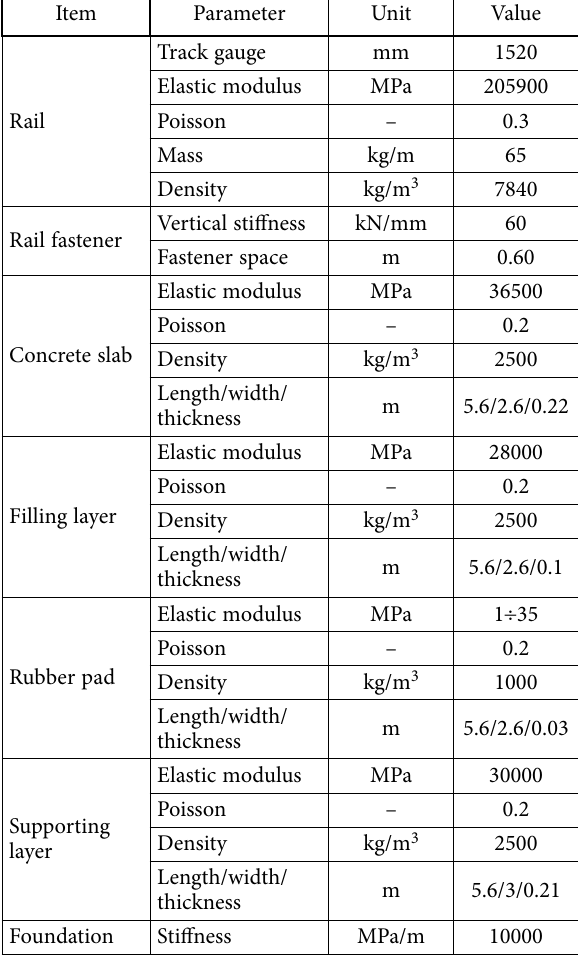
Table 2. Parameters of the slab